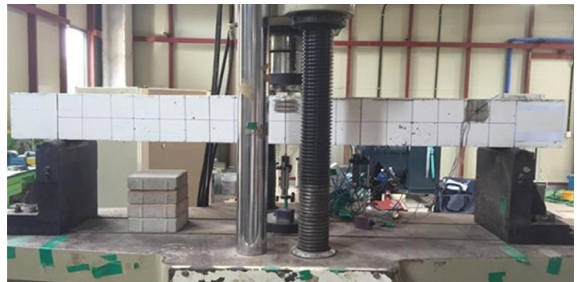
Figure 5: Static test of the RC beam specimen [25]. Table 3: Static test results of RC beams. Yield RC beam specimen